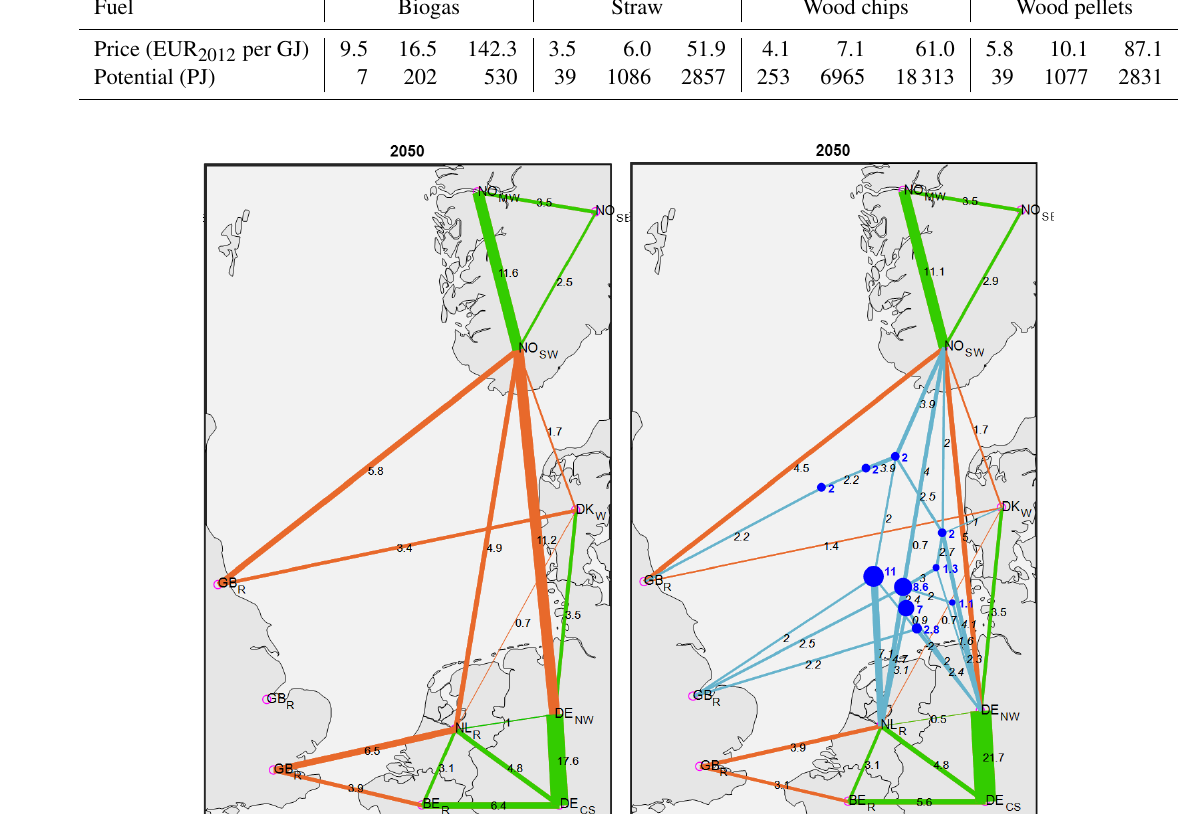
Figure 3. The resulting transmission and hub-connected offshore wind energy (in GW) by 2050 in the project-based (left) and offshore grid scenario (right). Green shows on-land lines, orange offshore country-to-country lines, light blue meshed offshore lines and dark blue hub-connected offshore wind power installations. The figures are taken from Koivisto et al.